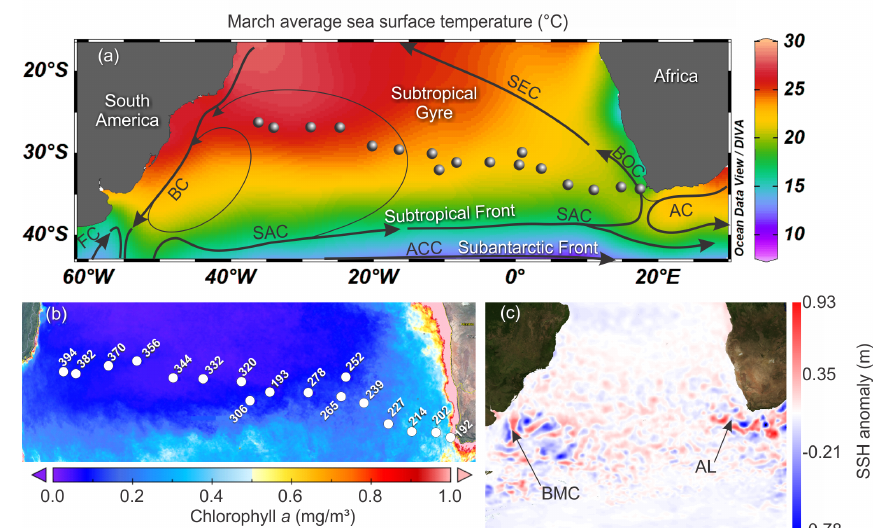
Figure 1. Map of the South Atlantic Ocean showing the locations of the stations of the M124 cruise. (a) March sea surface temperature (SST) from World Ocean Atlas 2013 and the main surface current systems (modified from World Ocean Atlas 2013 and Stramma and England, 1999). (b) Average 2002–2018 surface chlorophyll a measured by satellite from MODIS – AQUA. (c) Sea surface height anomaly above the sea level on 1 March 2016 (sampling of station 202) from Ssalto/Duacs (SAC – South Atlantic Current; ACC – Antarctic